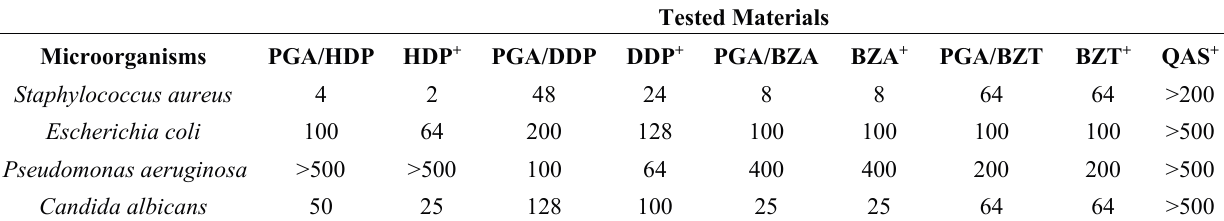
Table 2. Minimal inhibition concentrations (MICs) of PGAICs, partner cationic surfactants, and an organosilicon-type immobilizing surfactant QAS a .